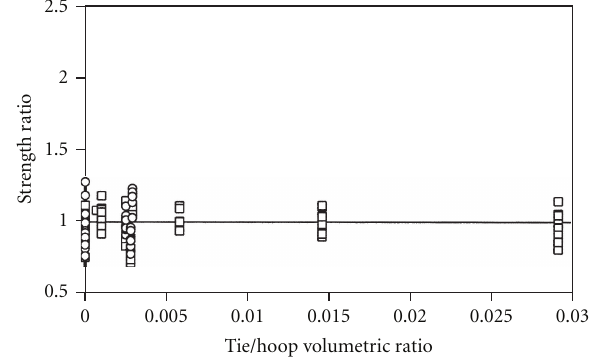
Figure 12: E ff ect of transverse reinforcement (tie/hoop) volumetric ratio ρ (cid:2)(cid:2) on FEM strength ratios for composite columns ( n = 111).